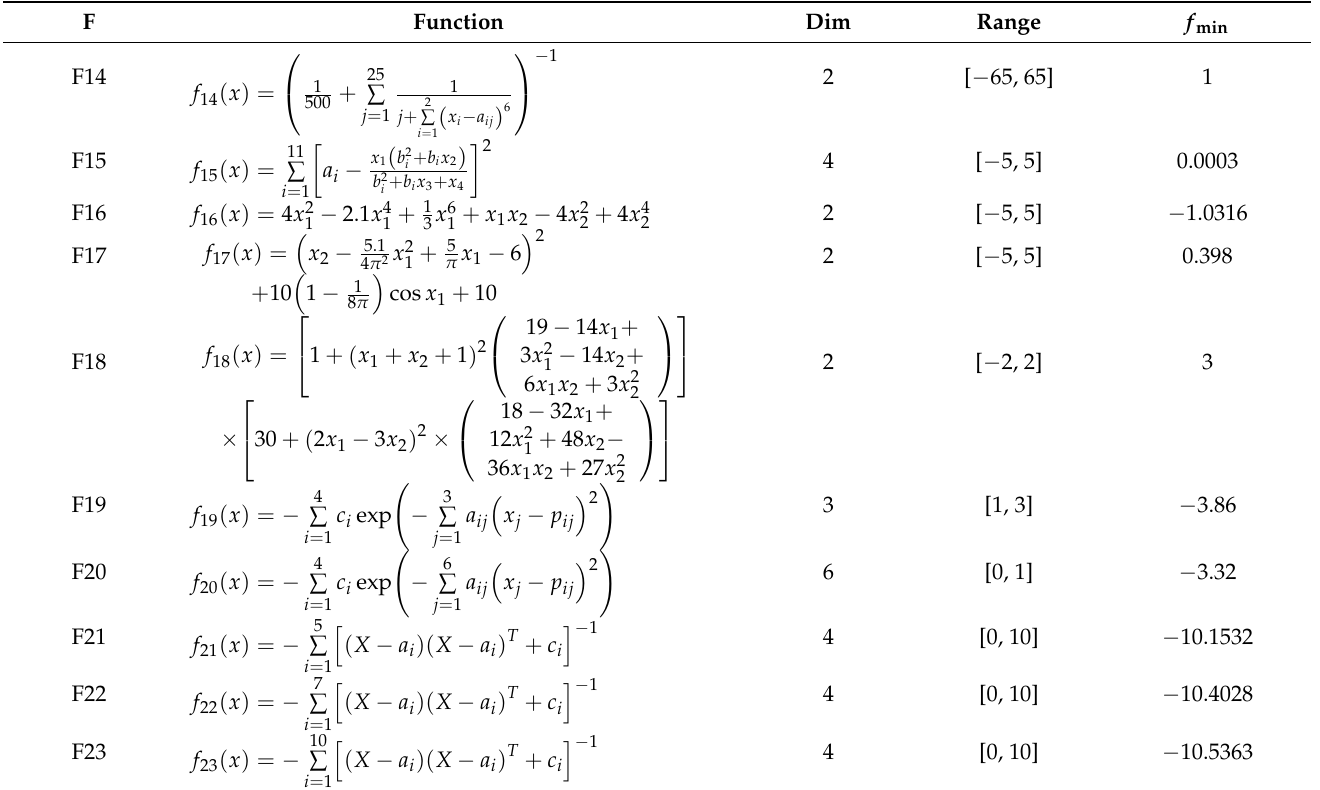
Table 4. Fixed-dimension multimodal benchmark